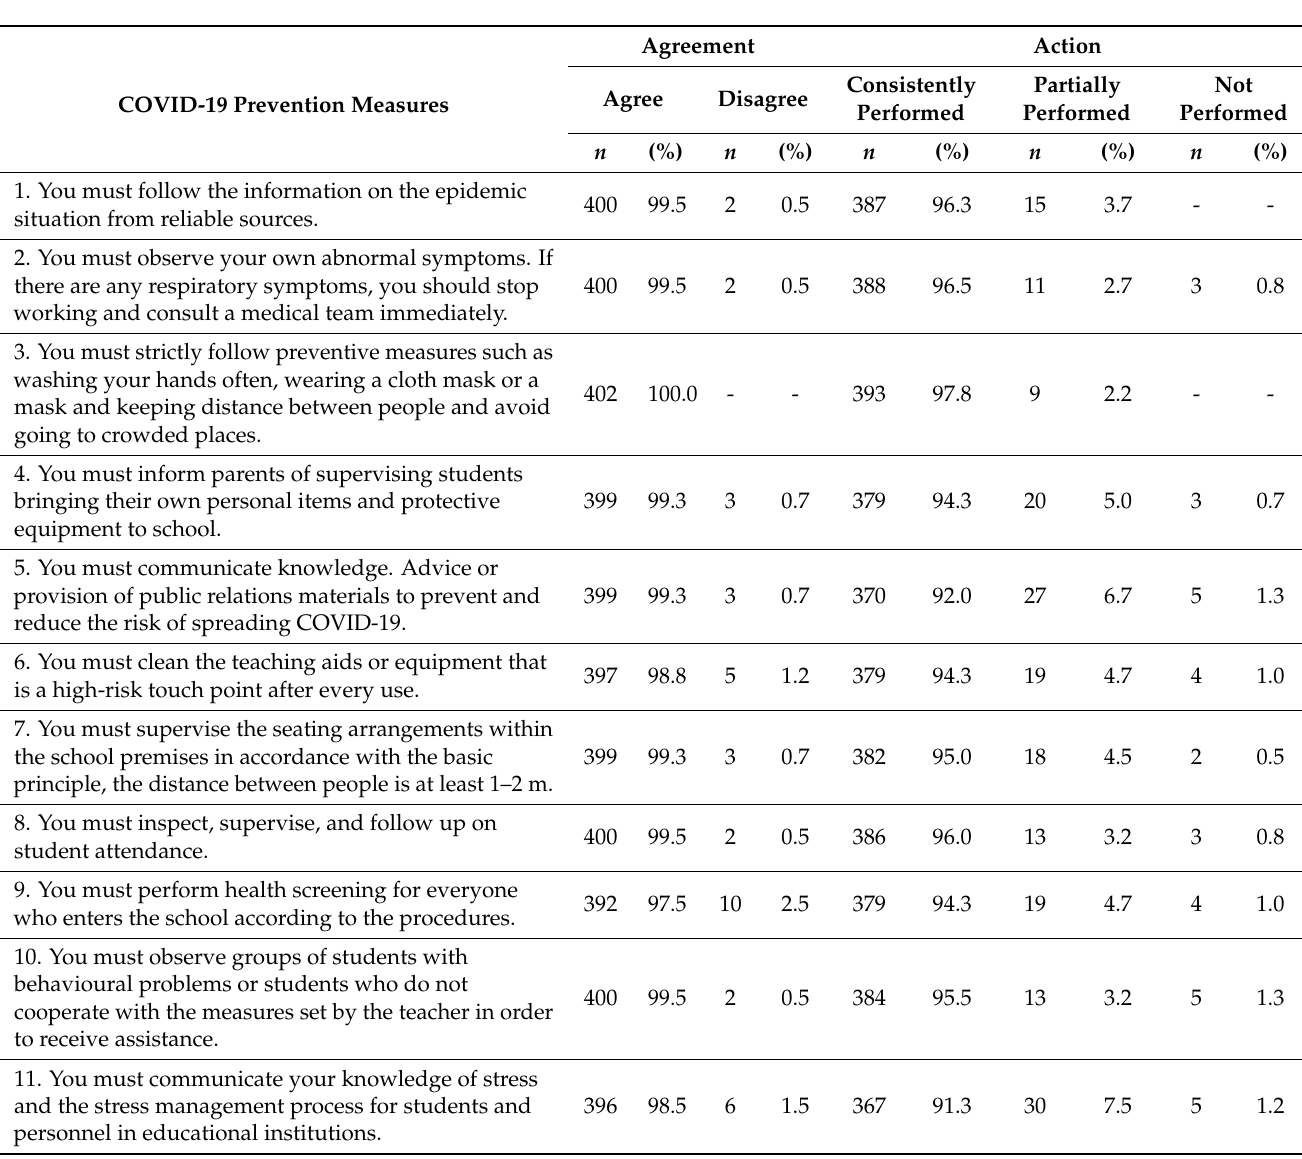
Table 2. Agreement and action regarding the measures and recommendations for the prevention and control of COVID-19 in